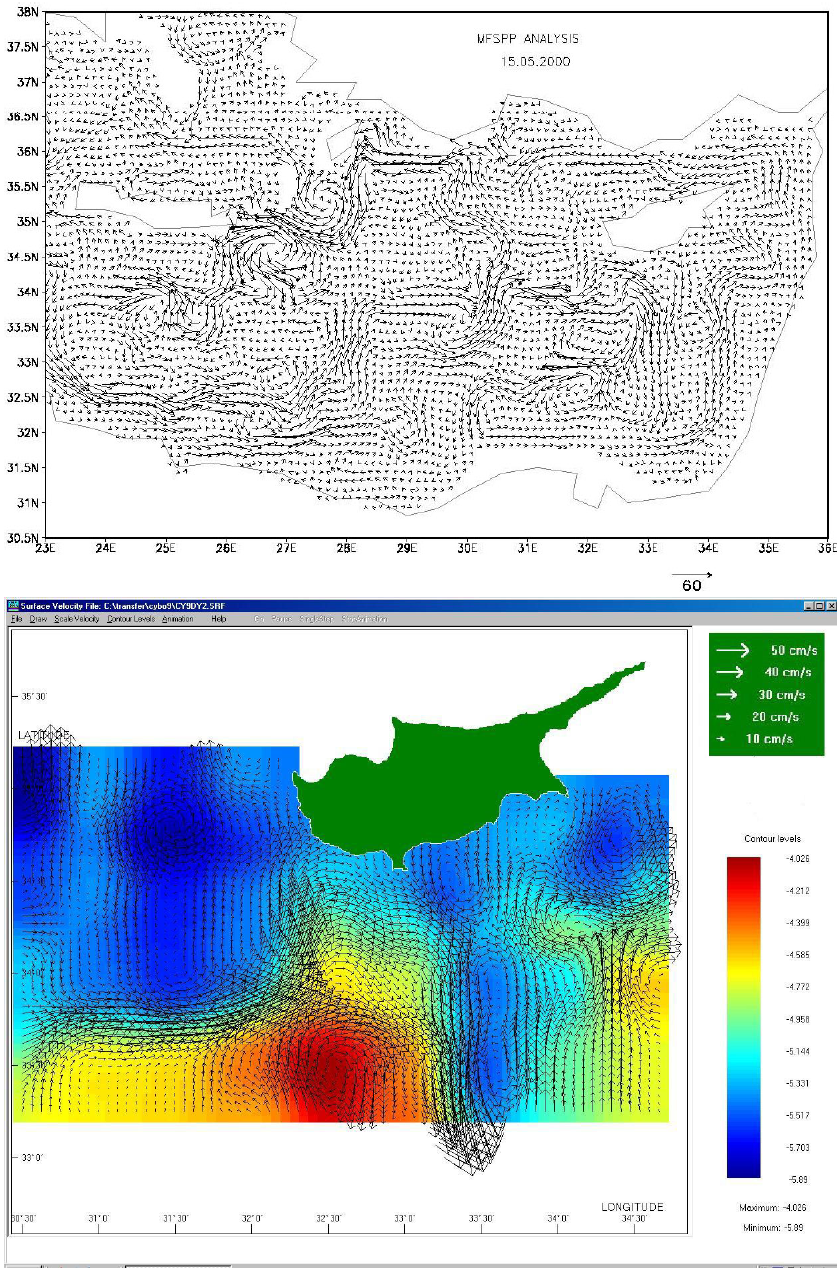
Fig. 9. Comparison of the circula- tion in the SE Levantine Basin at the 30m depth, between: (a) the OGSM NRT operational forecasts and (b) the geostrophic flow (currents + dynamic height) derived from the CYBO project, both during the TOP period, May